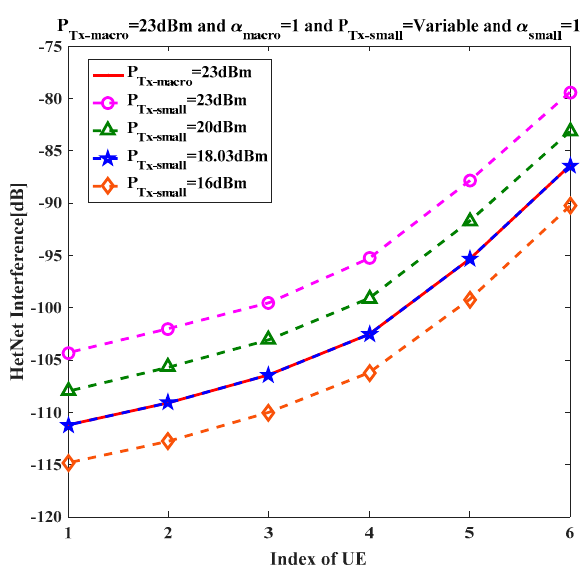
Figure 14. Interference comparison as a function of P max in the uniform macro cell and HetNet deployments.